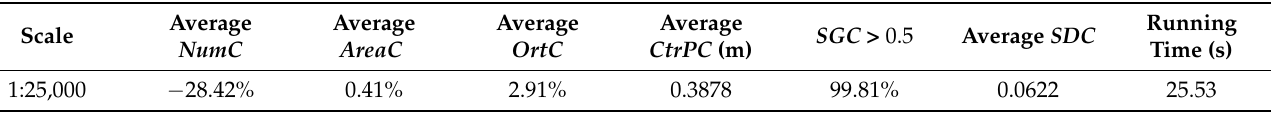
Figure 13. Simplification of buildings at scale 1:25,000: ( a ) simplified result in a clear view, and ( b , c ) are the enlarged views. Table 3. Evaluation indicators of the simplified result at scale